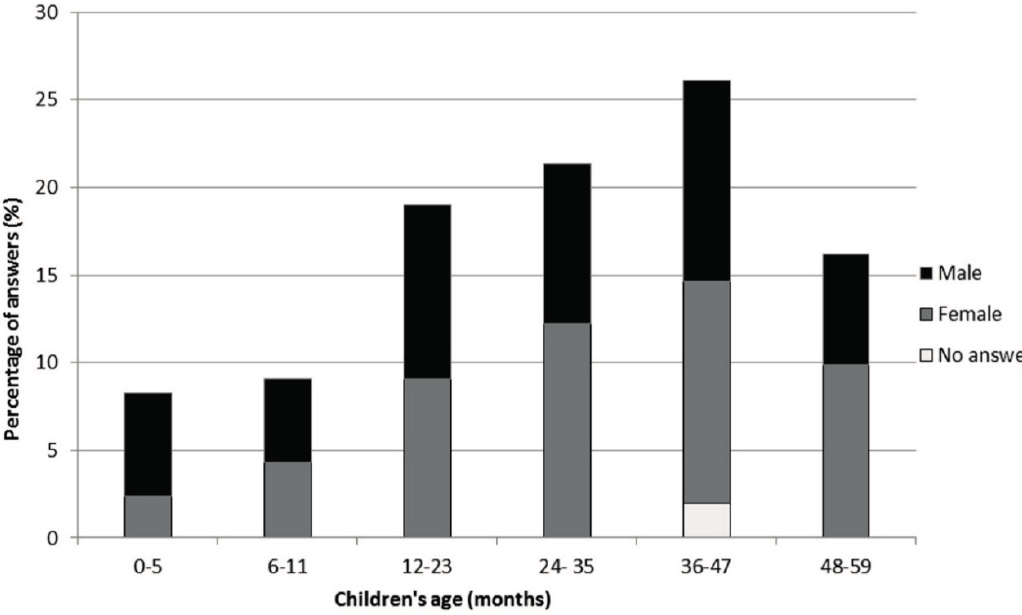
Figure 2. Distribution of inquired children by age and gender (total 253 responses).